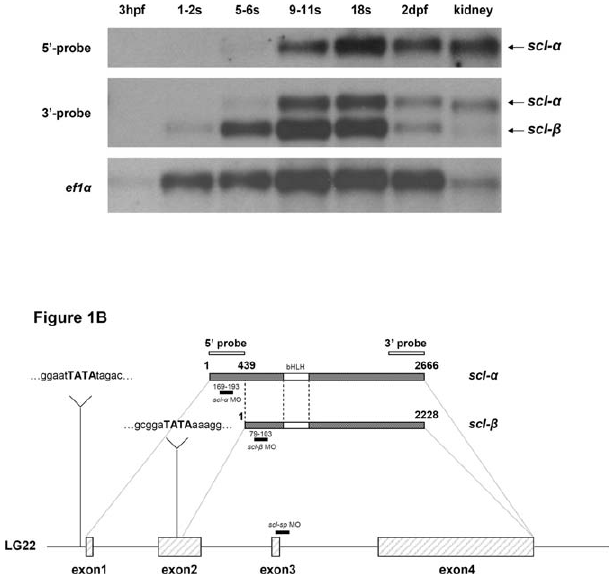
Figure 1. Identification of Zebrafish scl- b Isoform (A) Northern blot analysis of scl expression in 3-h, 1- to 2-somite (s), 5- to 6-somite, 9- to 11-somite, 18-somite, and 2-dpf embryos and adult kidney. The 3 9 -probe (3 9 UTR) recognized both scl- a and - b isoforms (middle), whereas the 5 9 -probe (5 9 UTR) detected only the full-length scl- a (top). ef1 a was used as the loading control (bottom). (B) Gene structures of scl- a and - b . scl- a consists of 4 exons (boxed regions). scl- b transcript is initiated from the middle region of exon 2, and a potential TATA-box sequence (indicated in bold capital letters) is predicted at position (cid:2) 31 of the transcription initiation site. The black bars indicate the positions of scl- a MO, scl- b MO, and scl-sp MO. The white boxes represent sequences that encode the basic helix-loop-helix